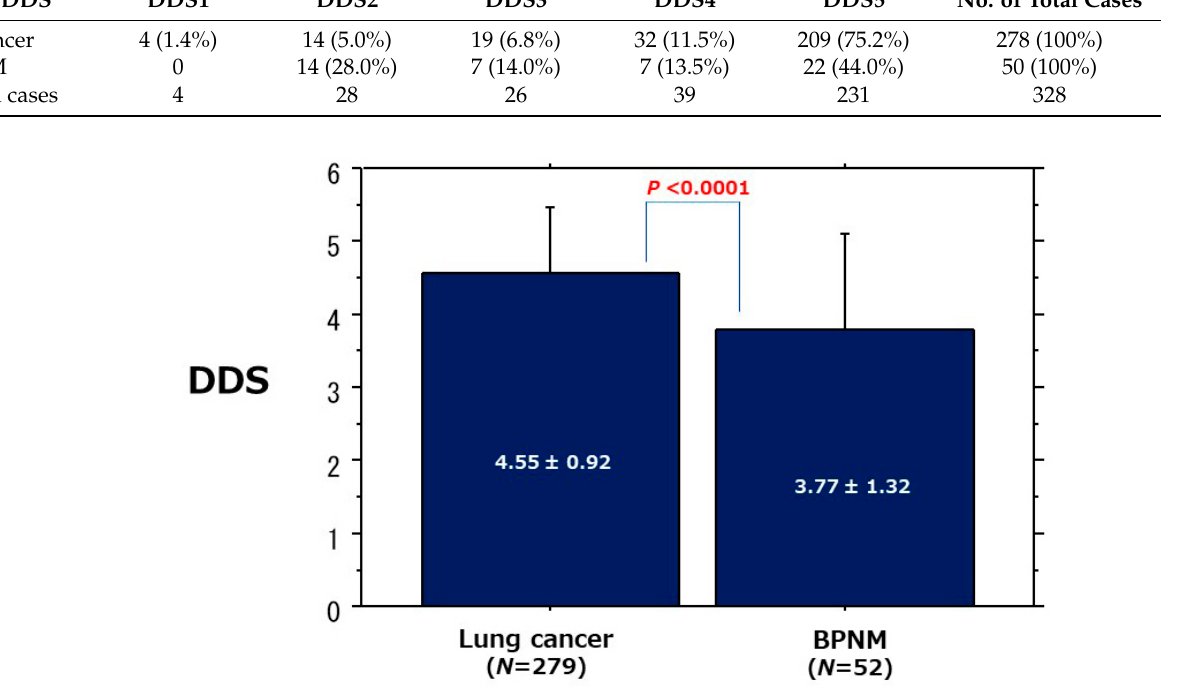
Figure 3. Acinar adenocarcinoma showed 2.17 for SUVmax, DDS 2, 1.67 × 10 − 3 mm 2 /s for ADC, and 1.34 for T2 CR. Yellow arrows shows PNMs.